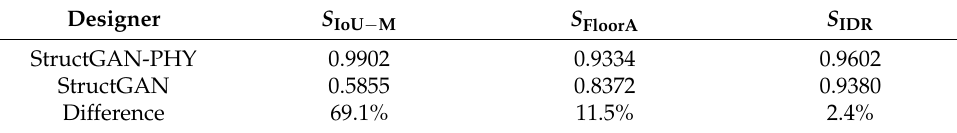
Table 1. Comparison between designs of data-driven and physics-enhanced